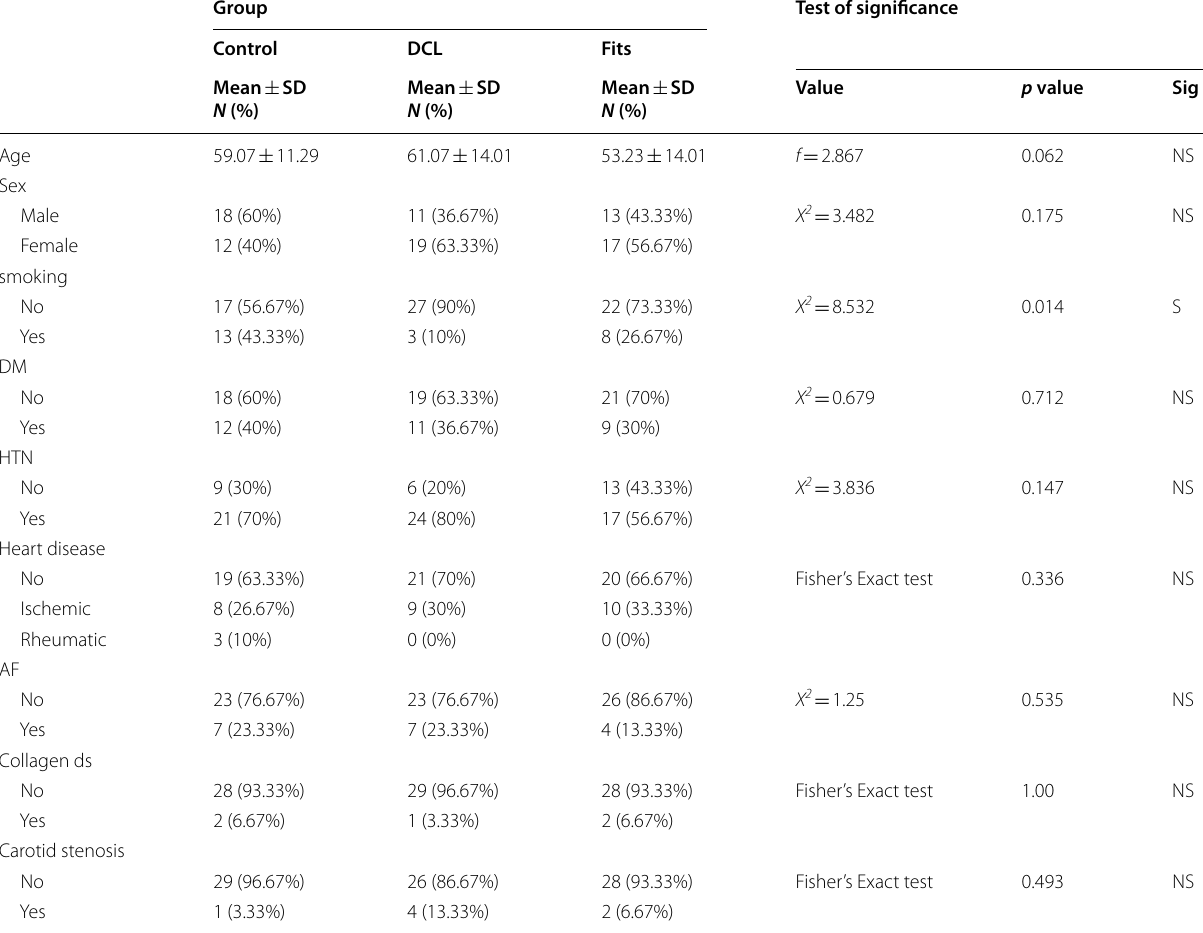
Table 1 Demographic data and risk factors